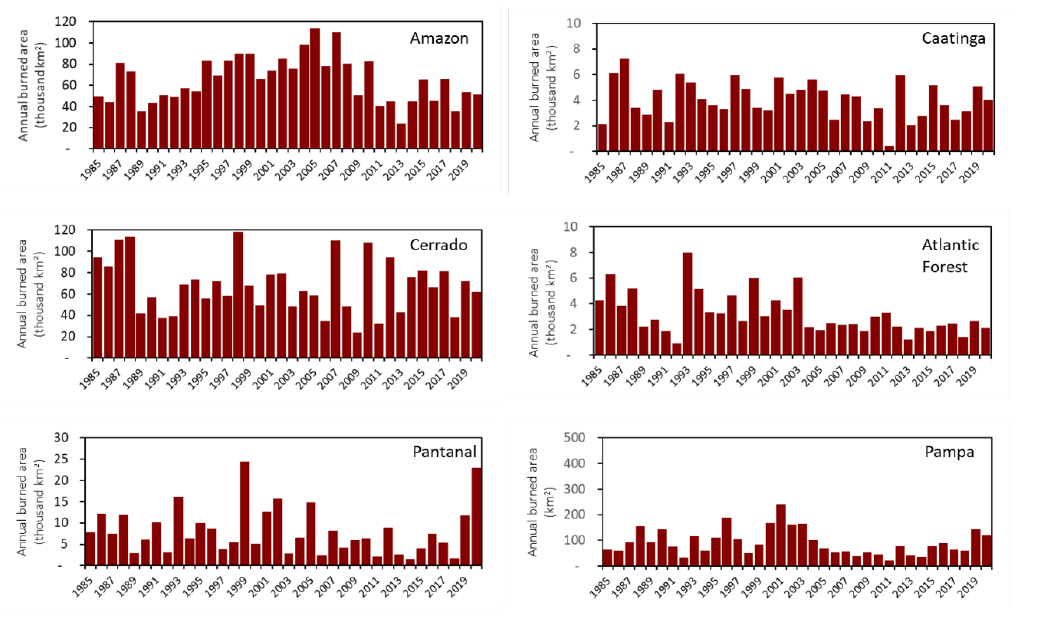
Figure 8. Temporal distribution of annual burned area by Brazilian biome between 1985 and 2020.